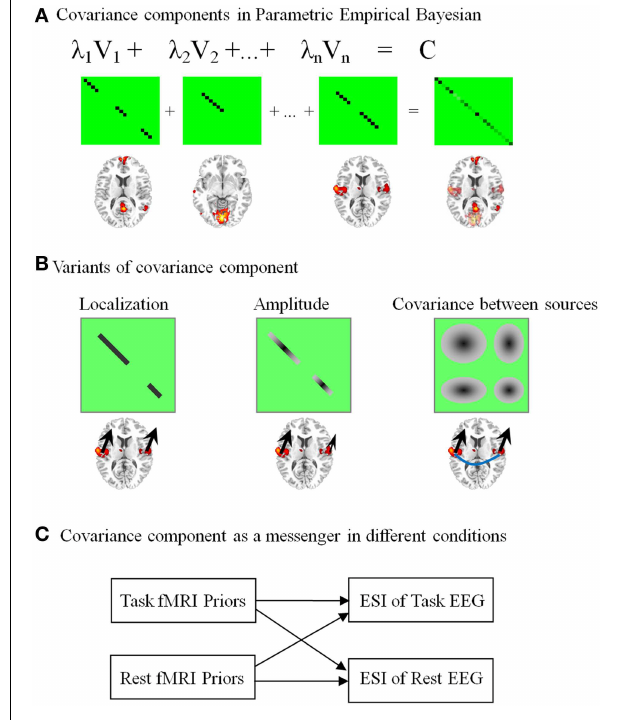
FIGURE 3 | Network-based source imaging and its variants. The brain maps represent the spatial pattern of the upper covariance components (CCs). (A) Temporally coherent networks derived from fMRI are employed as the CCs in parametric empirical Bayesian model. (B) Three different structures of CCs are illustrated: a covariance matrix with binary value only considers the location information from fMRI (the black arrows have the same size); a covariance matrix with continuous value assumes the magnitude of neuroelectric activity based on fMRI statistical quantities (arrows with different size); a covariance matrix with non-zero off-diagonal terms has a strong assumption that EEG sources in a fMRI cluster have coherent time course (the blue line between arrows). (C) CCs are messengers to transmit the information between task-evoked and resting-state brain